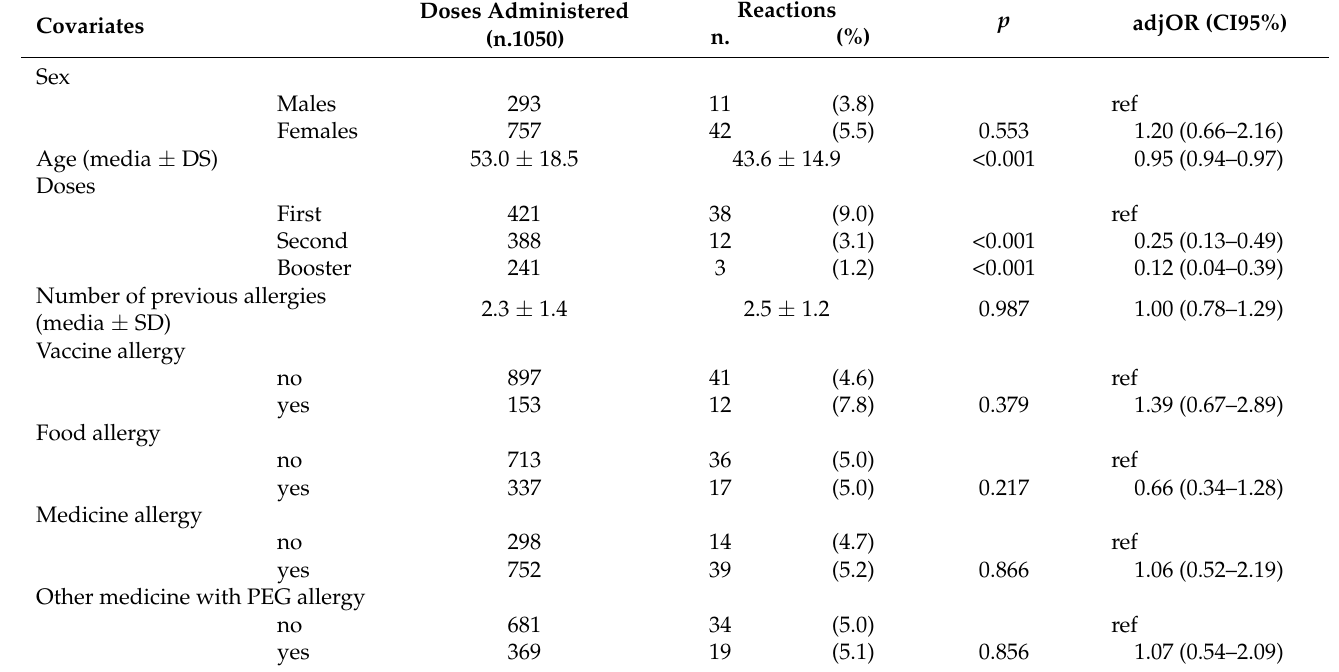
Table 2. Multivariate logistic analysis (y = at least one reported